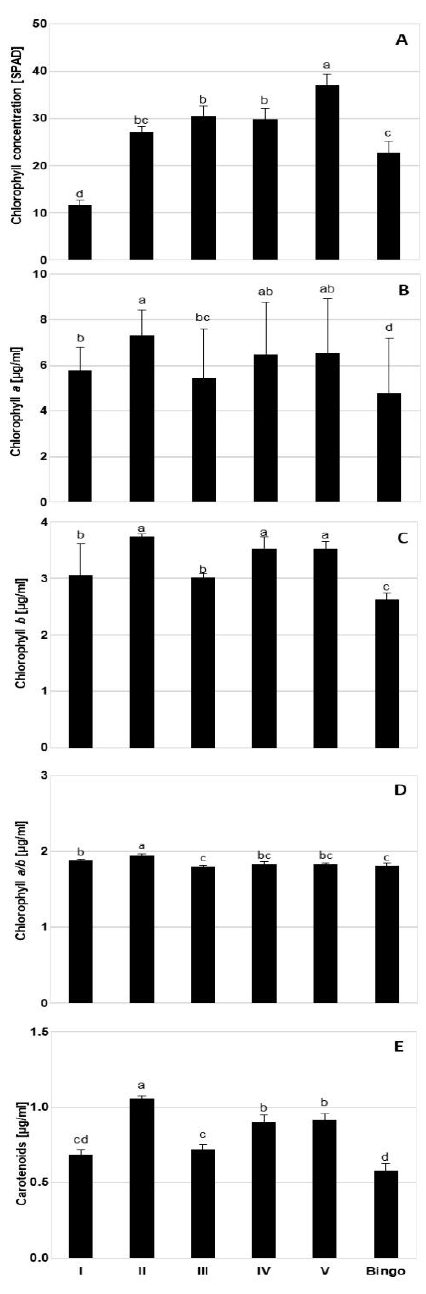
Figure 3. The content of photosynthetic pigments in the leaves of OMA (oat × maize chromosome addition) lines and cv. Bingo in control condition (70% field water capacity, FWC): ( A ) chlorophyll concentration [SPAD unit]; ( B ) chlorophyll a [µg/mL]; ( C ) chlorophyll b [µg/mL]; ( D ) chlorophyll a/b [µg/mL]; ( E ) carotenoids [µg/mL]. The mean values (n = 5) ± SE marked with different letters are significantly different at p ≤ 0.05 according to the Duncan’s multiple test.